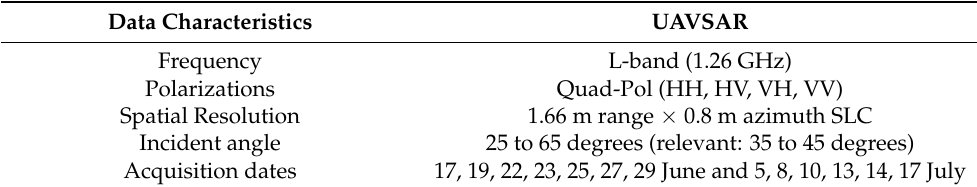
Table 1. UAVSAR sensor configuration and acquisition